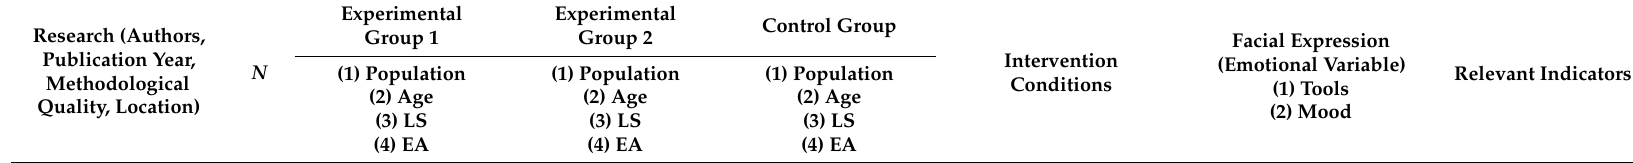
Table 1. Traits of interventional